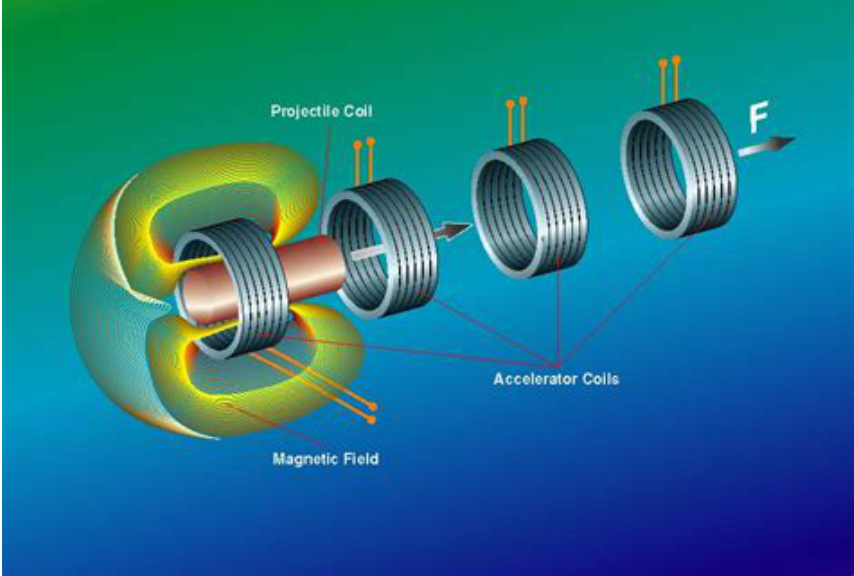
Figure 17. 3D diagram of a system with multiple coils